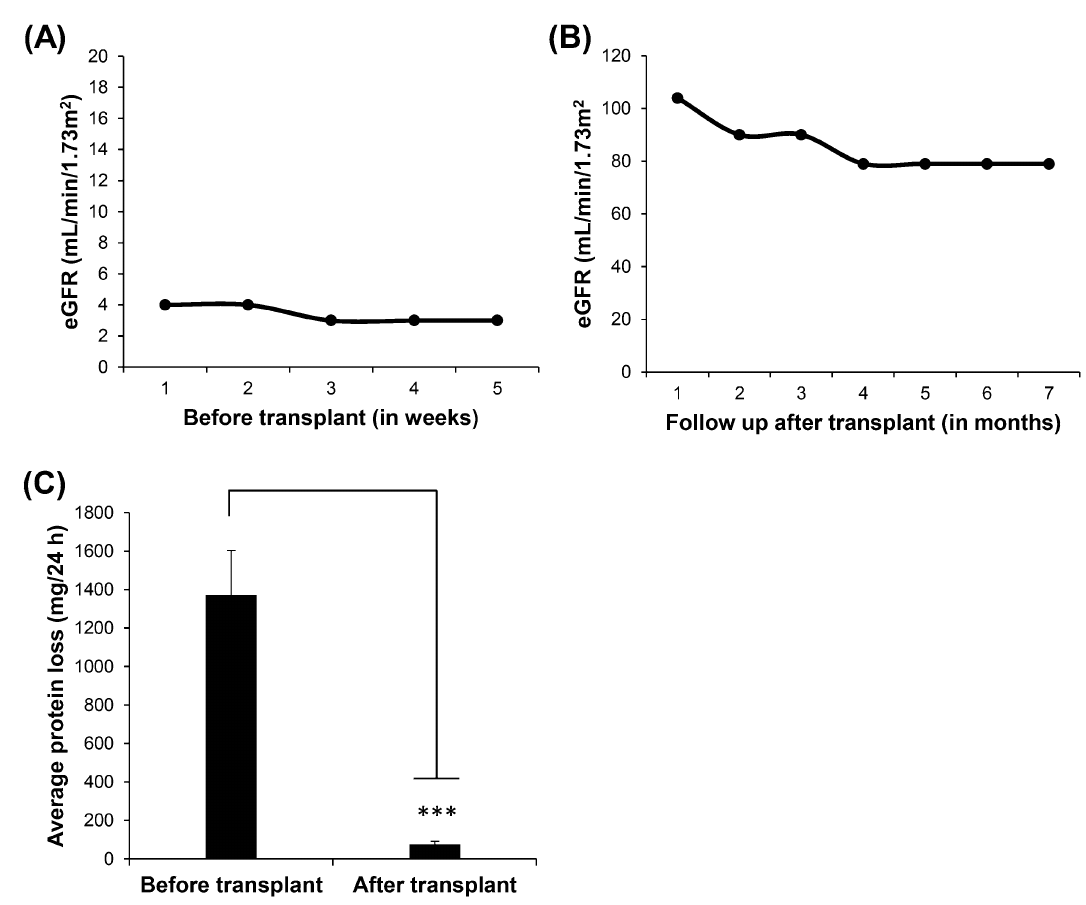
Figure 1. Pathophysiological characteristics of the proband (MC4, V-1). ( A ) Presenting the eGFR levels before dialysis treatment. ( B ) eGFR level after kidney transplant, showing the improvement in eGFR to the normal range. ( C ) Bar graph presenting the proteinuria (mean ± SE) before and after kidney transplant. The protein levels (mg/24 h) were considered only before the patient undergone dialysis. Mean (average protein loss) was calculated from three readings (intervals) in each category. ***p < 0.0001 statistically significant, using Student’s